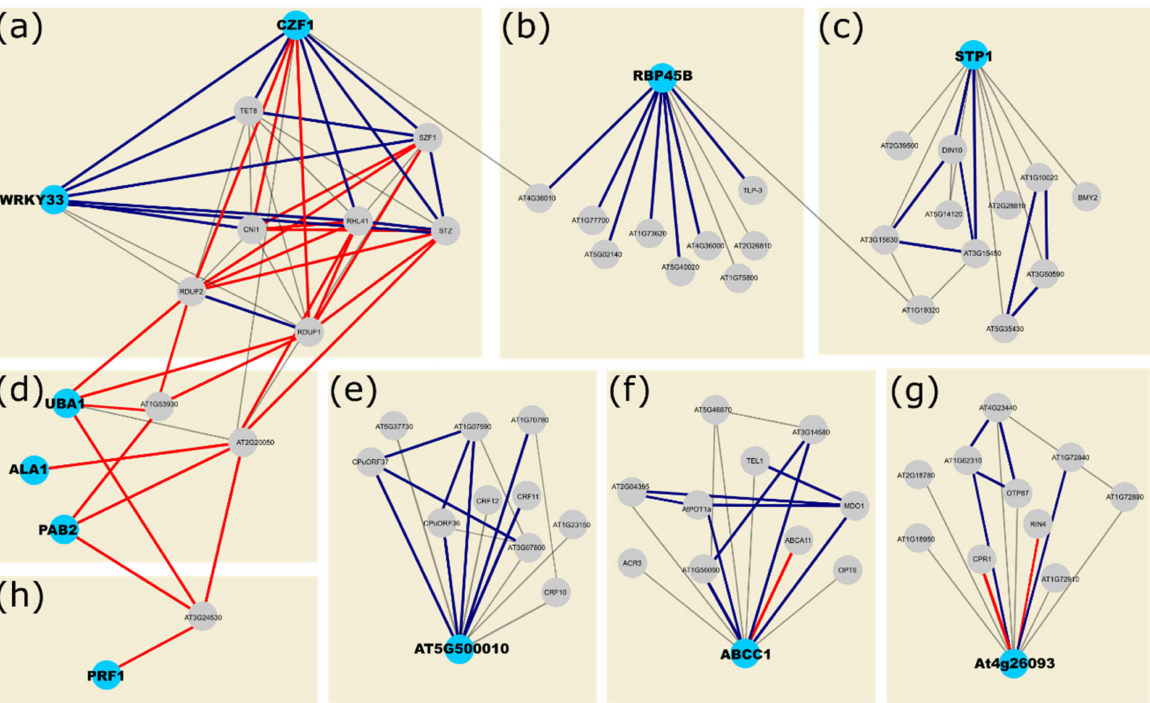
Figure 4. Protein-protein interaction (PPI) network of Arabidopsis thaliana protein orthologues with sequences expressed in cupuassu pulp and seeds (Table 2). ( a ) Functional cluster corresponding to biotic and abiotic stresses and transcriptional regulation. ( b ) Functional cluster corresponding to mRNA metabolism. ( c ) Functional cluster corresponding to the transmembrane transport of monosaccharides and carbohydrates. ( d ) Functional cluster corresponding to metabolism and translo- cation of phospholipids. ( e ) Functional cluster corresponding to responses to biotic (response to chitin and fungi) and abiotic (cold and hypoxia) stresses. ( f ) Functional cluster corresponding to the transmembrane transport of abscisic acid. ( g ) Functional cluster corresponding to defence response to pathogens and responses to biotic and abiotic stresses. ( h ) Development of leaves, inflorescences, and lateral roots. Blue nodes correspond to initial sequences (used in expression analysis), and grey nodes were aggregated by the String program to build the network. Thick red, thick dark blue, and thin grey edges correspond to experimental, coexpression, and text-mining relationships between nodes,